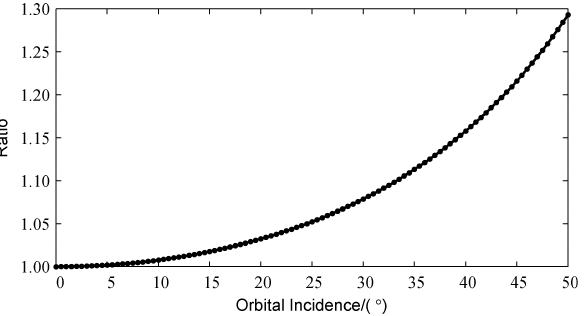
Figure 7. Ratio simulations of the orbit incidence